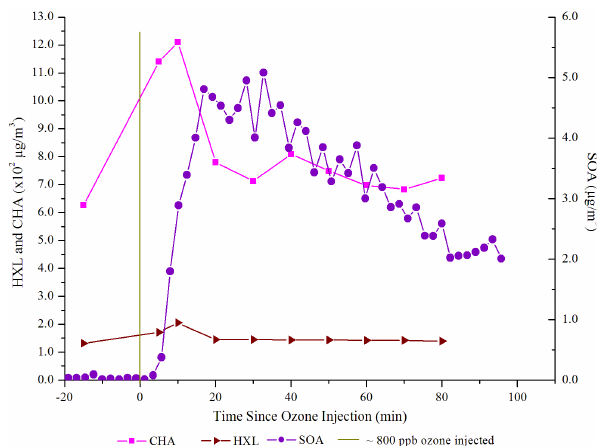
Fig. 7a. Zero air was flushed through grass clippings and into the experimental chamber, carrying with it GVLs contained in the grass headspace. Maximum concentrations of CHA and HXL (12 ( ± 1) × 10 2 µgm − 3 and 2.05 ( ± 0.01) × 10 2 µgm − 3 , respectively) were measured post-ozonolysis, which we believe was due to in- complete mixing within the experimental chamber before ozone in- jection. Ozone data were not available, but at time zero ∼ 800ppb ozone was injected (indicated by vertical line) and within 20min HXL concentration dropped below the instrument detection limit while SOA reached its maximum wall-loss-corrected concentra- tion (15.7µgm − 3 ). CHA remained relatively constant after the first 20min of the reaction (0.74 ( ± 0.05) × 10 3 µgm − 3 ) and was never completely consumed. Lines between data points drawn to aid the eye.